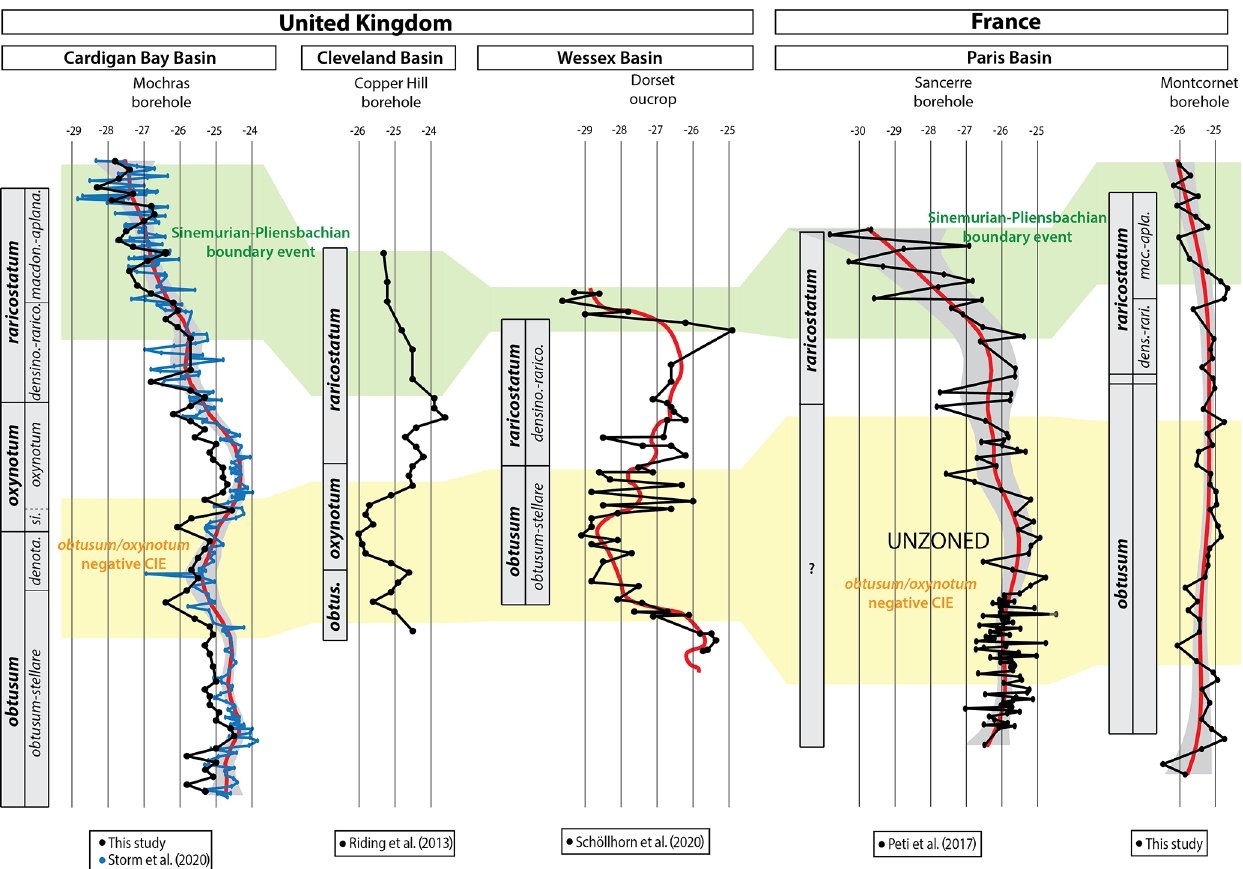
Figure 10. Correlation of the negative excursion of δ 13 C org during the upper Sinemurian in Cardigan Bay Basin (this study; Storm et al., 2020), Cleveland Basin (Riding et al., 2013), Wessex Basin (Schöllhorn et al., 2020a) and Paris Basin (this study; Peti et al.,